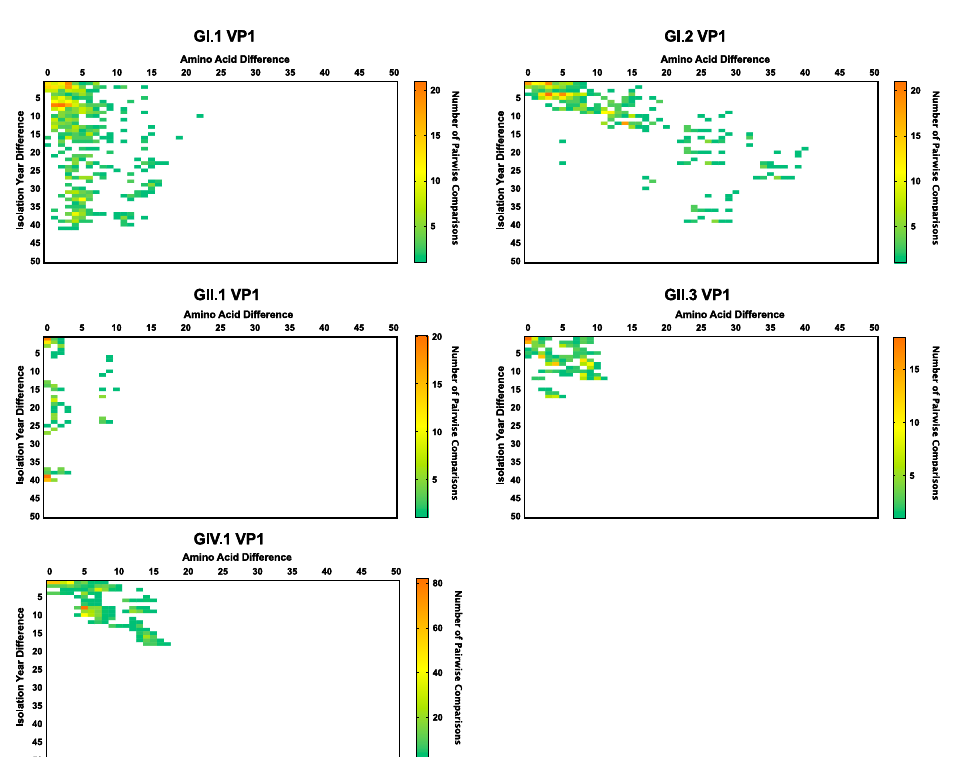
Figure 4. Temporal amino acid diversity patterns of VP1 capsid protein from major sapovirus genotypes. Comparison of patterns reveal differences in VP1 diversification. Over a 40-year period, GI.1 strains differ by 15-20 amino acids, whereas GI.2 strains differ by up to 40 amino acids. The heat map represents the number of pairwise comparisons among available sequences, red being the highest and green the lowest number of pairwise comparisons.